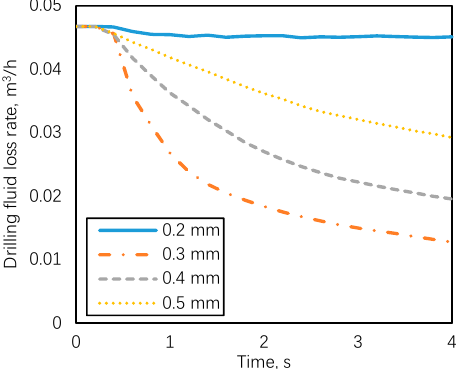
Figure 14. The drilling fluid loss rate at different simulation moments.